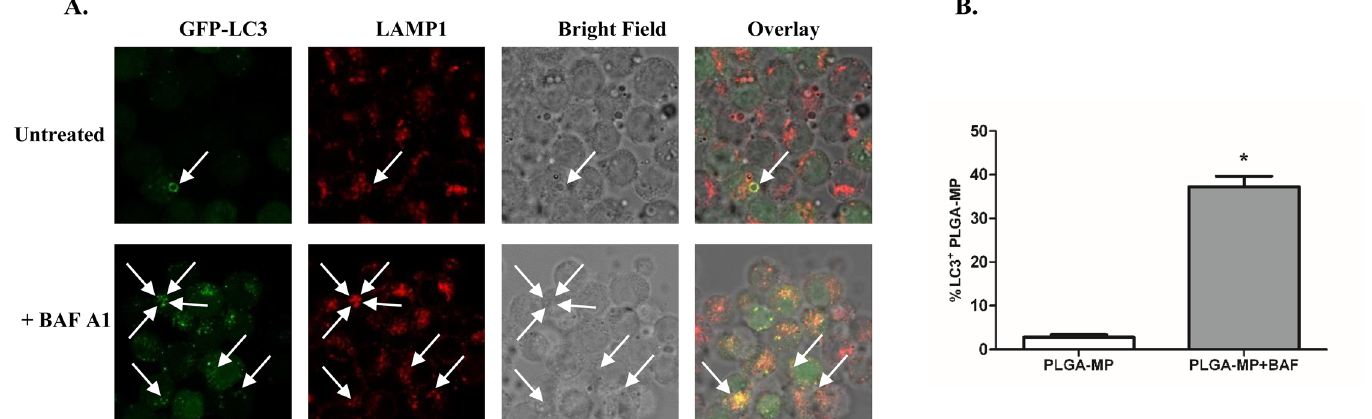
Fig 5. PLGA MPs phagocytosis triggers autophagic flux in macrophages. (A) Immortalized murine BMDMs expressing GFP-LC3 incubated with PLGA-MP for 3 hours in the presence of bafilomycin A1 (30nM) or vehicle (DMSO) were subjected to immunofluorescent staining for LAMP-1 and imaged by confocal microscopy to determine (B) the proportion of PLGA MP co-localising with GFP-LC3 which are reported as mean +/- SEM.of three independent experiments, * p < 0.05. The white arrows indicate localization of GFP-LC3 with PLGA MPs. LAMP1 staining was included to aid in the visualization of MP